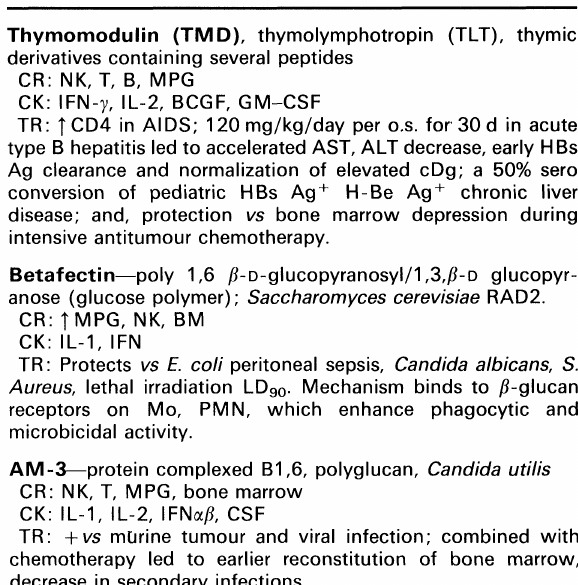
Table 9. Biological response modifiers of thymus and various origin